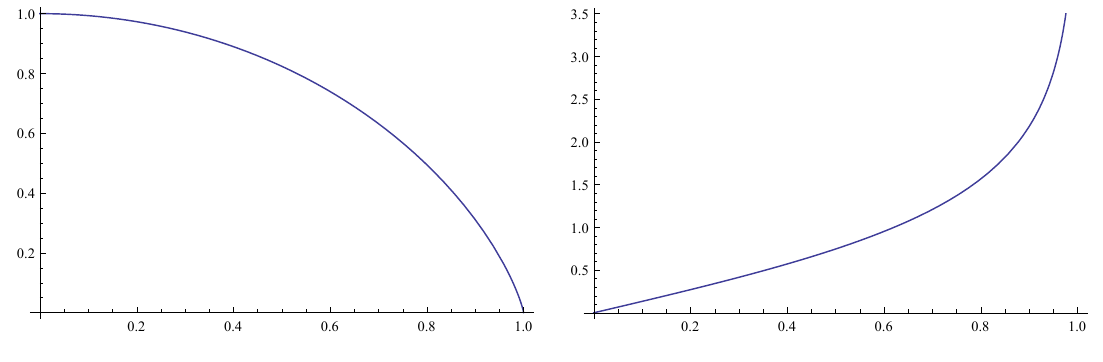
( x ) / 2 πρ R as a function of | x | / R . Right: base